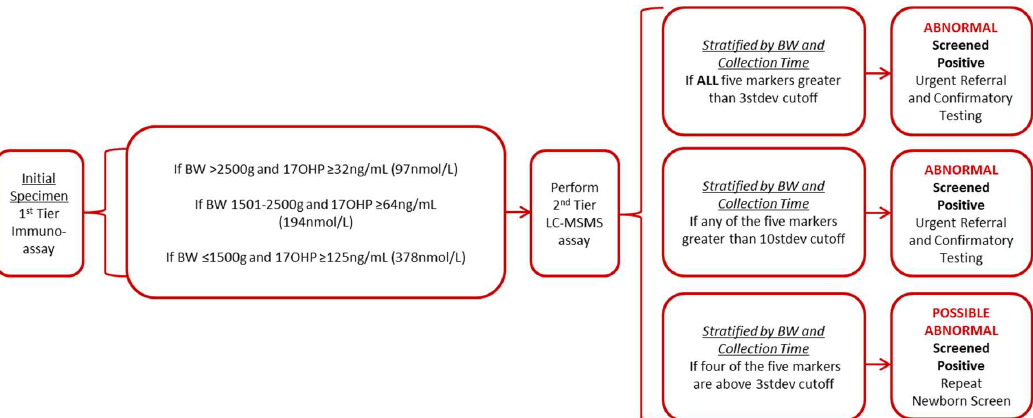
Figure 1. Newborn screening algorithm for congenital adrenal hyperplasia. Figure 1 provides the screening algorithm used to detect cases of congenital adrenal hyperplasia which includes both the first-tier assay and the second-tier assay, stratified by birth weight and collection time, and the corresponding interpretation guidelines. The five markers used for interpretation are 17OHP, 4-A, 21, [(17-OHP + 4-A)/F] and [(17-OHP+21)/F]. BW = birth weight.